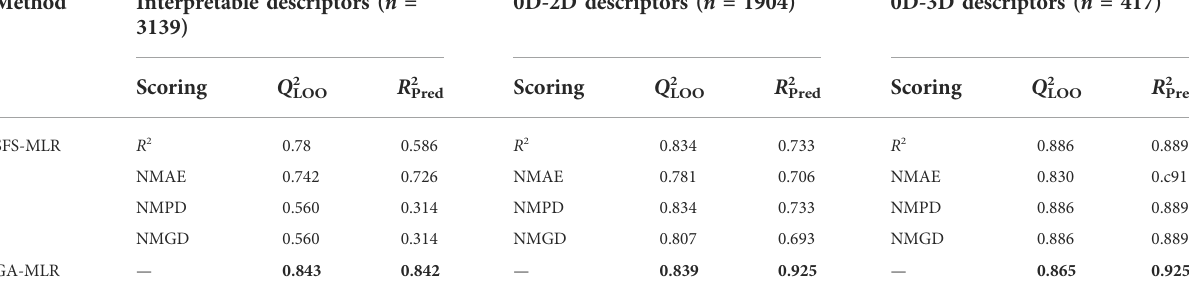
TABLE 1 Summary of the results obtained from 2D-QSAR modeling performed with the selected interpretable descriptors, 0D-2D and all 0D-3D descriptors a .